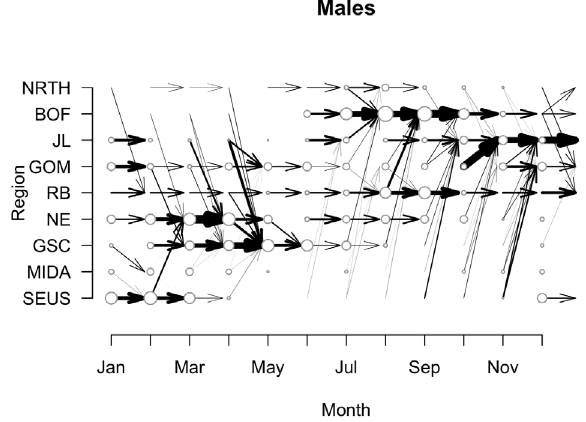
Figure 5. Movement transitions for male right whales. Posterior estimates of transitions made by male right whales between regions over the course of the year. Size of the circles in each region at each month correspond to the actual number of male right whales observed. Lines connecting regions indicate probability of transition, p jkt . 0.25. Magnitude of probability is depicted by line thickness.